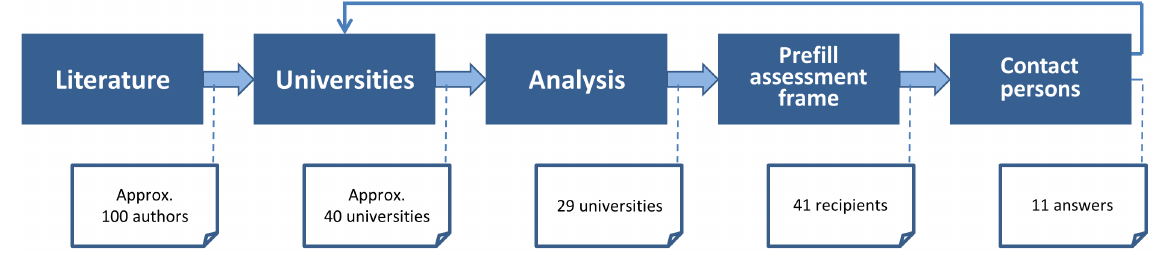
Figure 2. Overview of the search process